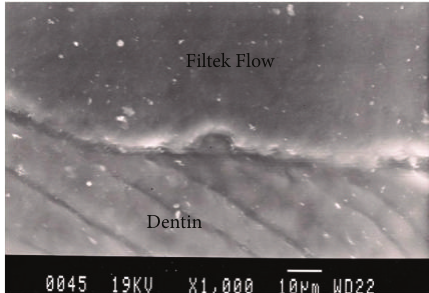
Figure 3: Representative SEM photomicrograph of a Group 3 spec- imen (Filtek Flow + Filtek Z250, light-cured separately). Good adaptation between Filtek Flow and dentin is observed.